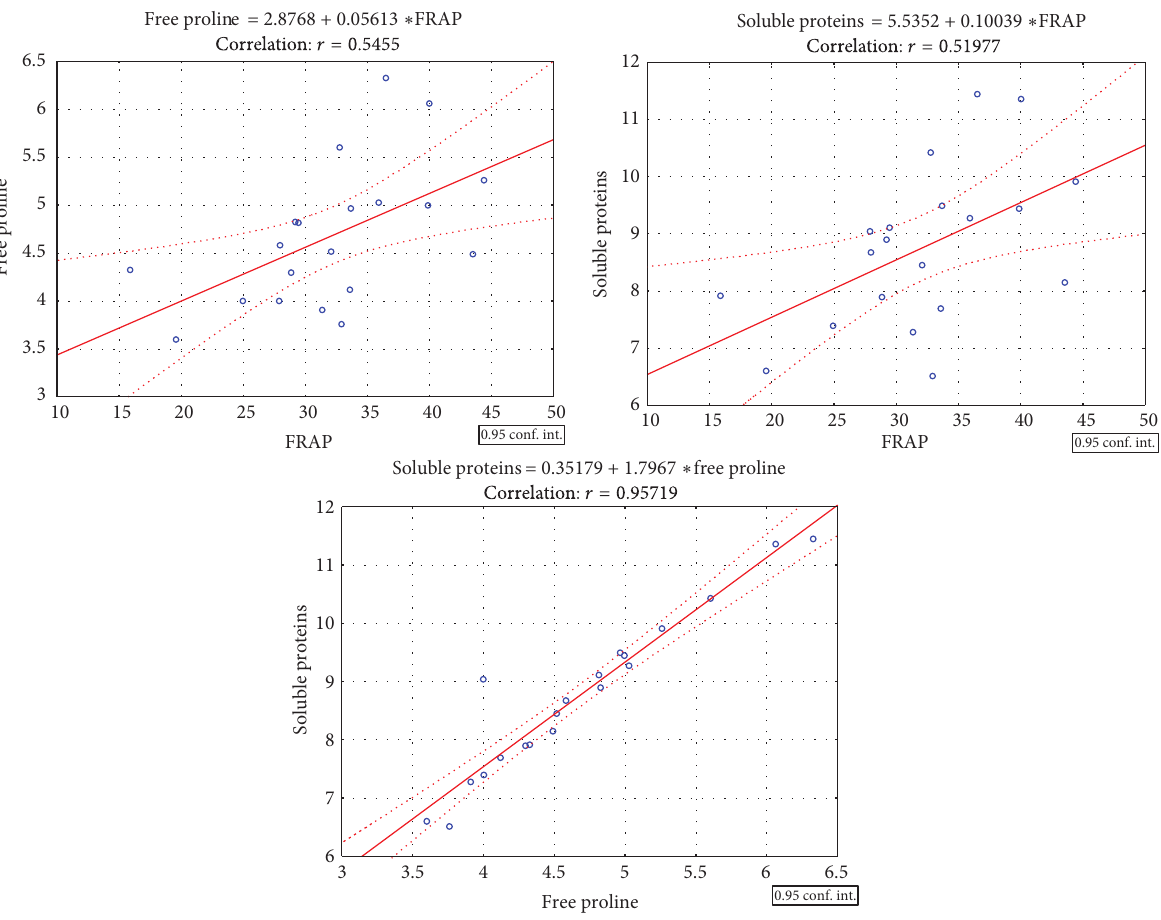
F 1: Signi�cant and positive correlations between di�erent parameters (free proline, FRAP, and soluble proteins) in beech provenances in forest Fruška